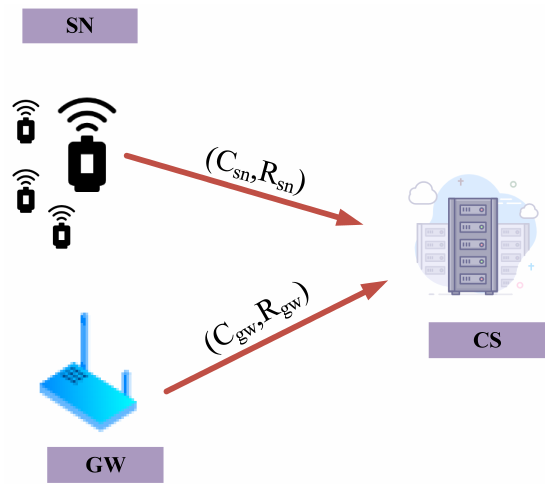
Figure 3. Registration